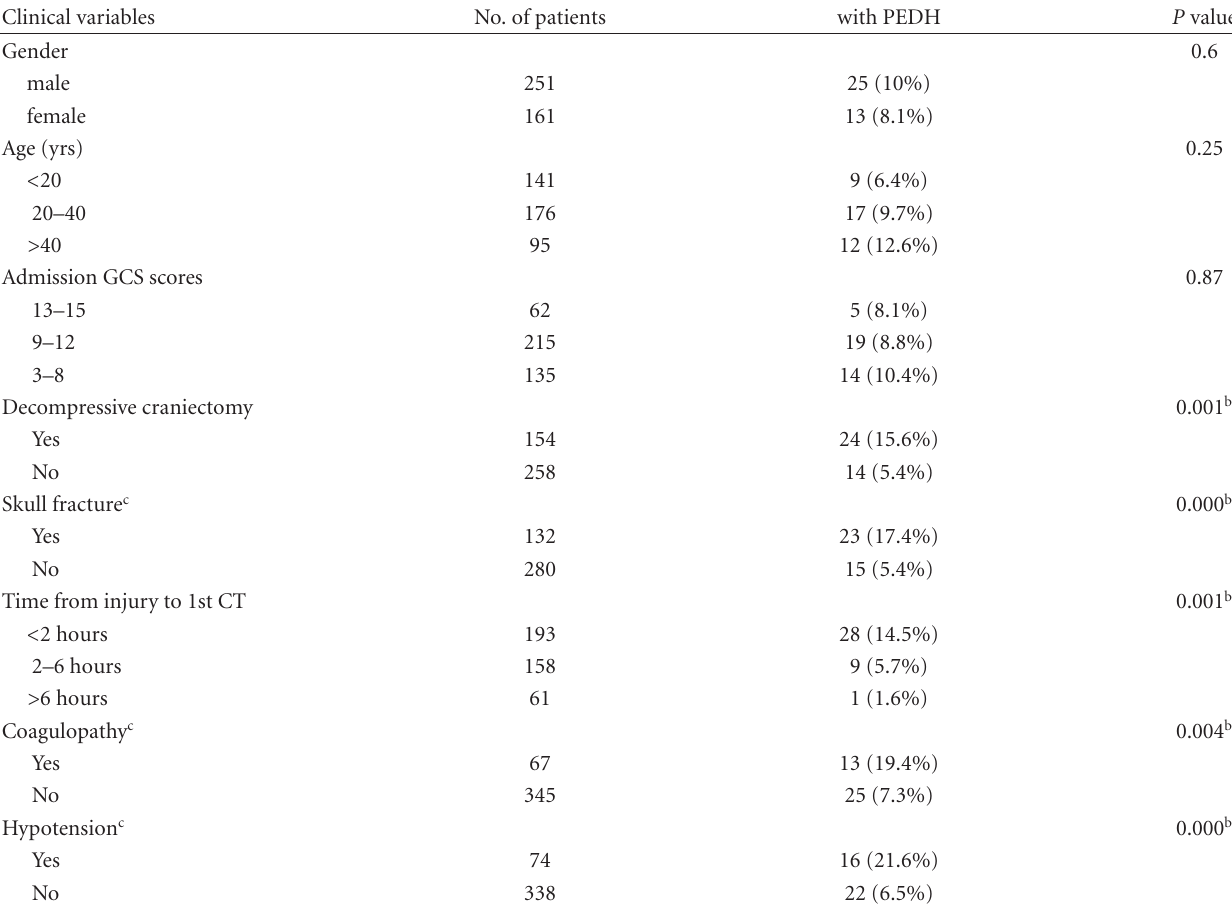
Table 2: Clinical variables related to the development of PEDH in the patients with head trauma.